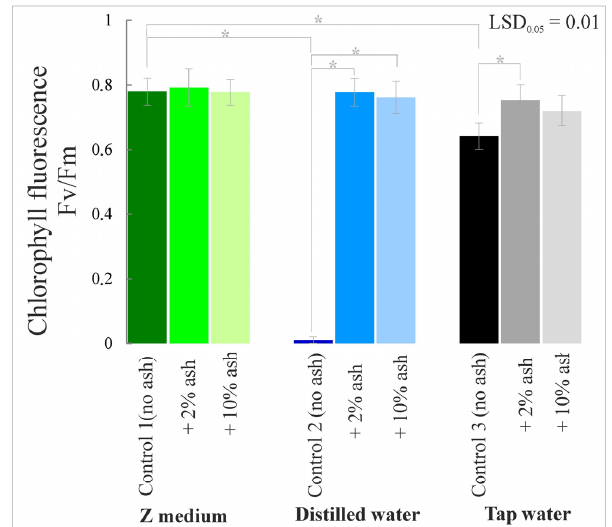
Figure 8. Chlorophyll fluorescence in S. polyrrhiza plants grown on different variants of ash-supple- mented media. Bars denote means ± SE; asterisks show statistically significant differences between particular series; LSD at alpha level of 0.05. between particular series; LSD at alpha level of